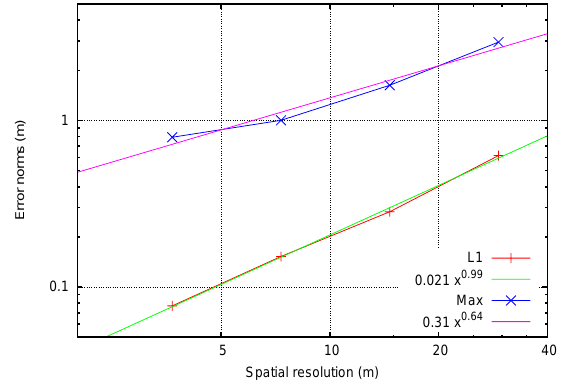
Fig. 3. Convergence of the average and maximum errors with spa- tial resolution. The errors are for the predicted wave profile at t = 220s.